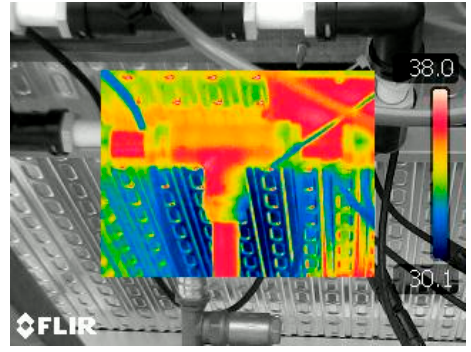
Figure 10. Detail of a tee piece of the PVT collector by thermal imaging camera.